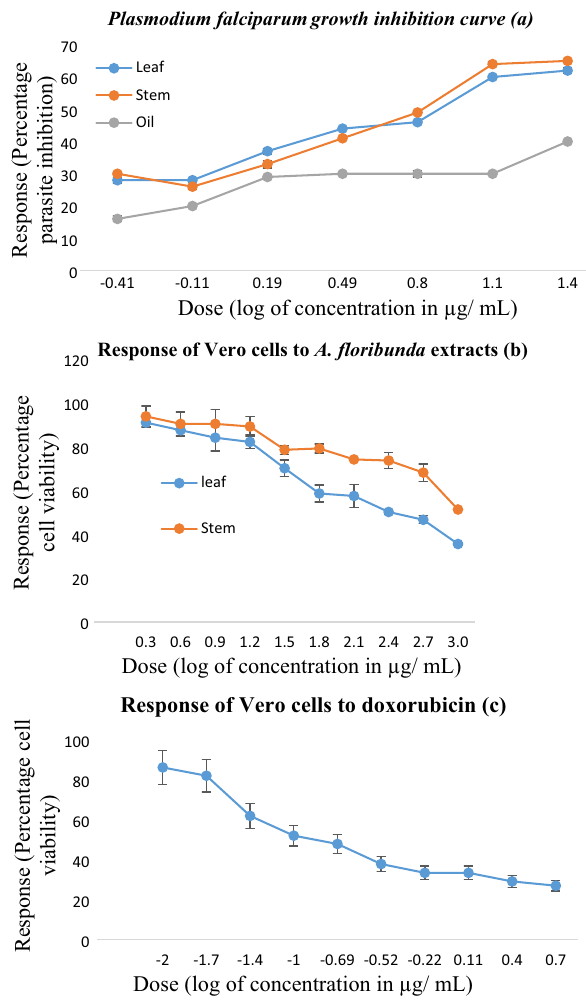
Fig. 1 Effects of A. floribunda extracts on: Plasmodium falciparum ( Pf3D7 ) growth using Mark III test and cell viability in Vero cell using MTT